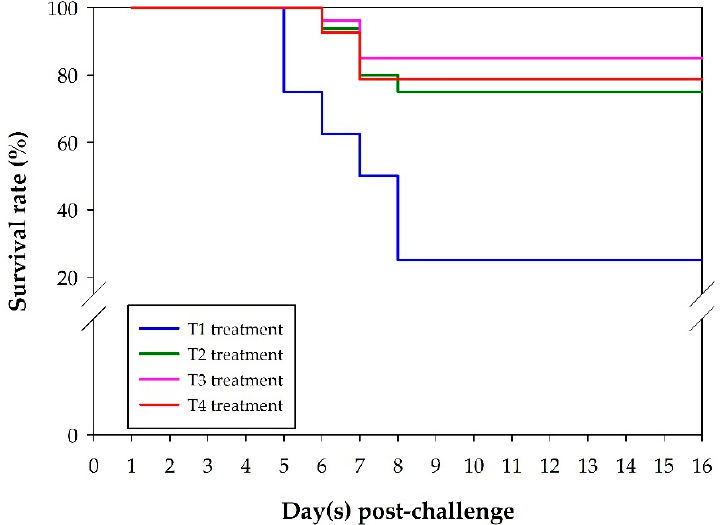
Figure 4. Kaplan–Meier analysis of O. niloticus ( n = 10) challenged with S. agalactiae after 15 days of immunization. Treatment 1 (T1)—control, Treatment 2 (T2)—formalin ‐ killed S. agalactiae immersion